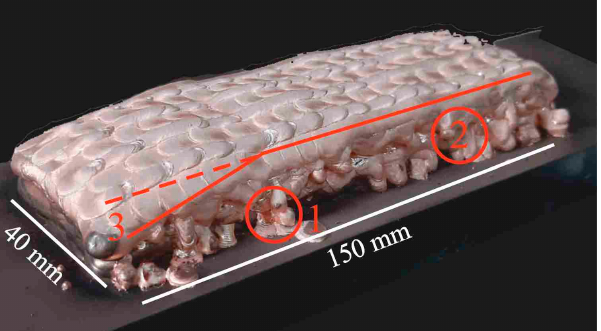
Figure 4. Macrostructure of A-type blocks fabricated using scanning strategy 2 with electron beam wire-feed additive technology. Noted defects by type: 1—droplets, 2—leaks and 3—decrease in the height.